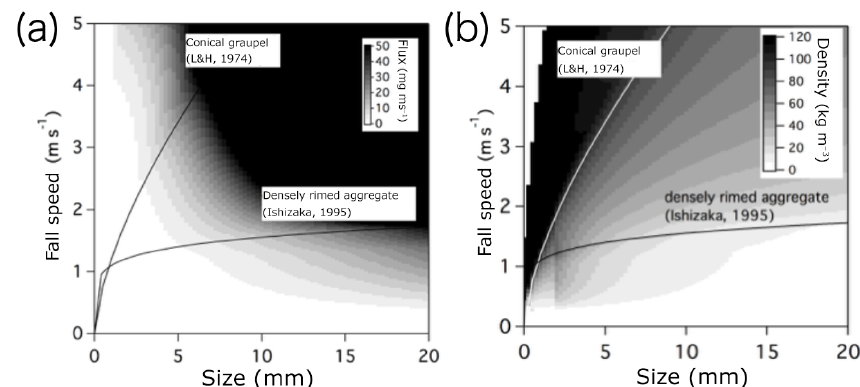
Figure 9. (a) Mass flux chart – a graphical expression of the mass flux table, which indexes the mass flux calculated in advance for each bin of a given size and fall speed. (b) Density chart – a graphical expression of the density table that indexes density, calculated by dividing the mass deduced from the mass flux table by the volume of the sphere of diameter equal to the bin size. The two curves represent relationships for conical graupel (from Locatelli and Hobbs, 1974, denoted as L&H 1974 on the graph) and densely rimed aggregate (from Ishizaka,